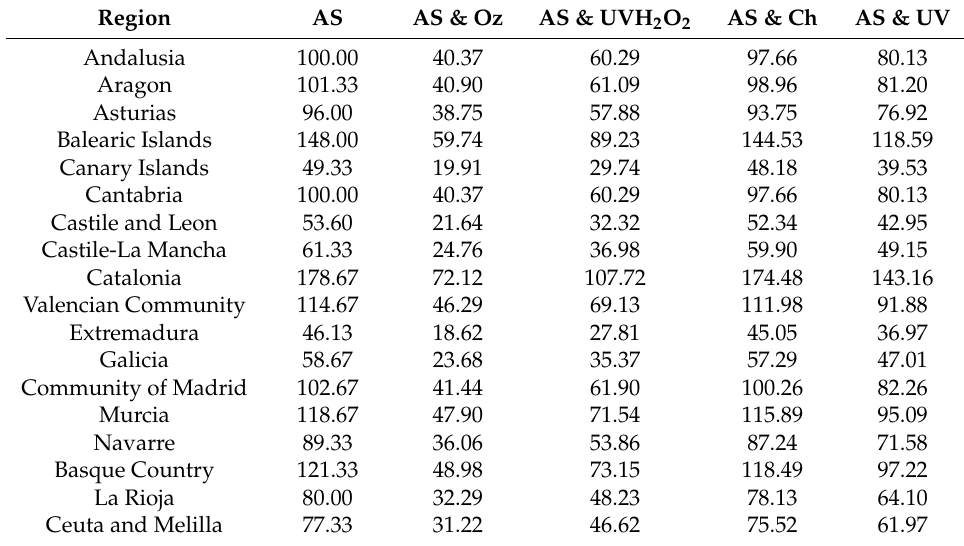
Table 4. Financing capacity of different treatments in the Spanish regions in 2014